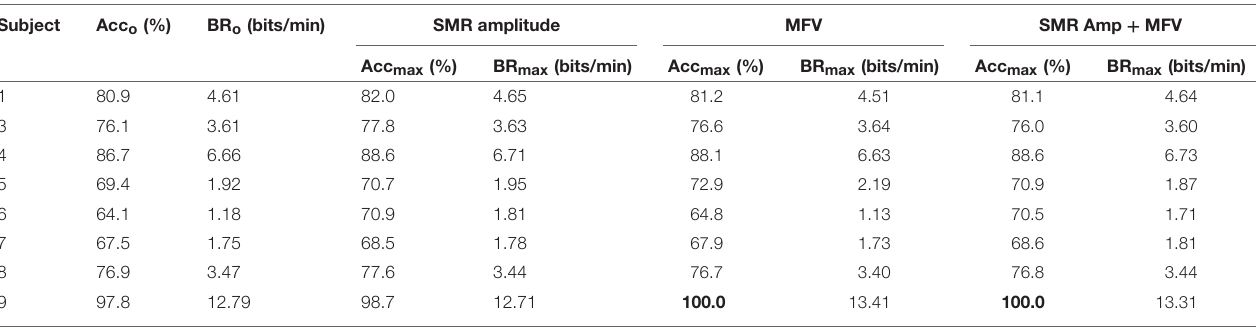
TABLE 4 | Simulated gating results.